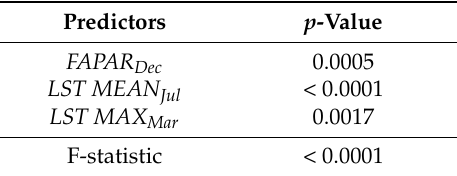
Table 1. p -values and F-statistics of the predictors selected with the stepwise regression modelling approach.